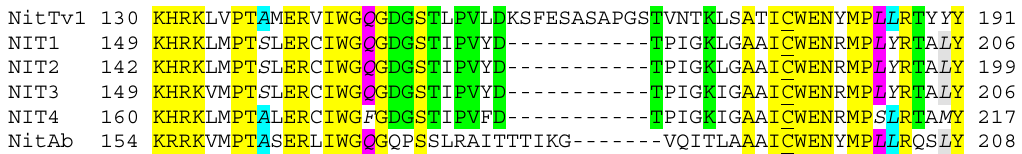
Figure 1. Multiple sequence alignment of the catalytic regions in plant nitrilases from Arabidopsis thaliana (NIT1–NIT4) and fungal nitrilases NitTv1 and NitAb. The catalytic C residue is underlined. Amino acid residues conserved in all sequences are in yellow. Those conserved in NitTv1 and plant NLases are in green. Amino acid residues conserved in the NIT1/NIT2/NIT3 type and different in NIT4 type are in italics. The residues identical in NIT1/NIT2/NIT3 and fungal NLases are in magenta and those identical in NIT4 and fungal NLase in blue. The residues identical in NIT1/NIT2/NIT3 and NitAb (but different in NitTv1) are in grey.